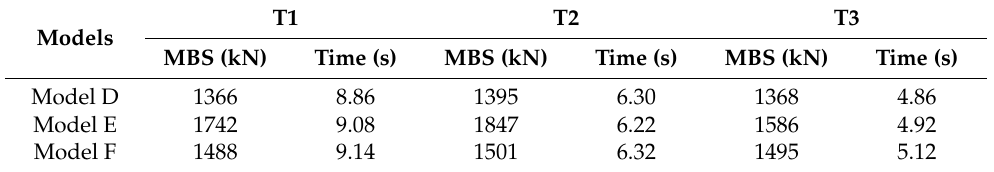
Table 9. The maximum base shear in the Y-direction.